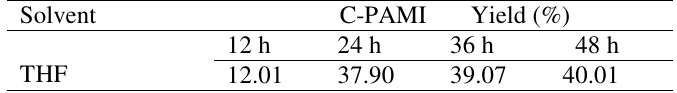
Table 3. Radical copolymerization of N-PAMI and MMA in different